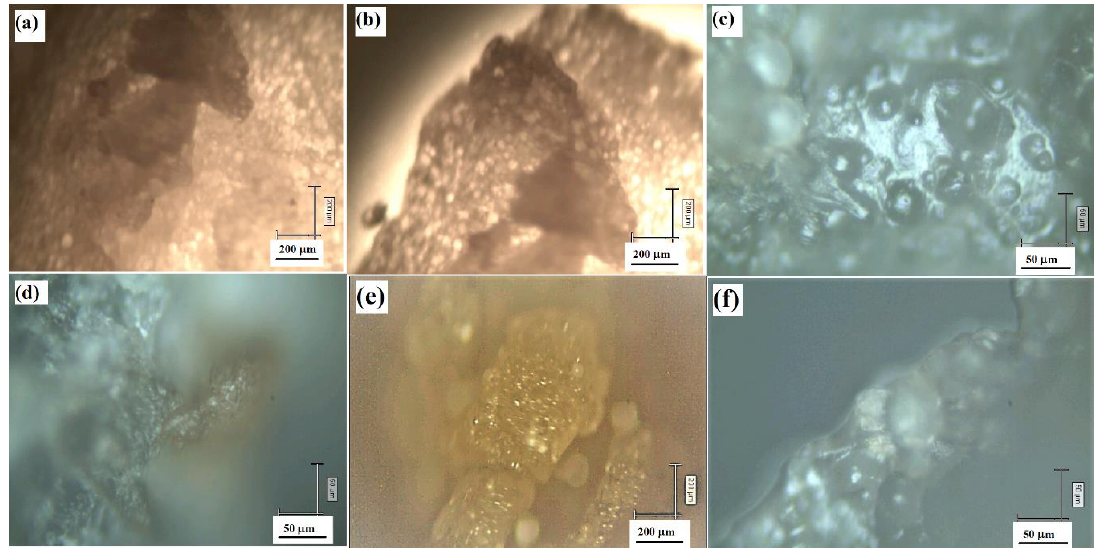
Figure 8. Micrographs corresponding to multiple acquisition performed on different sites of the surface of acrylic cement debris. The images shows details of the acrylic cement surface in contact with the ( a , b ) metallic component and with ( c – f ) the biologic tissue.